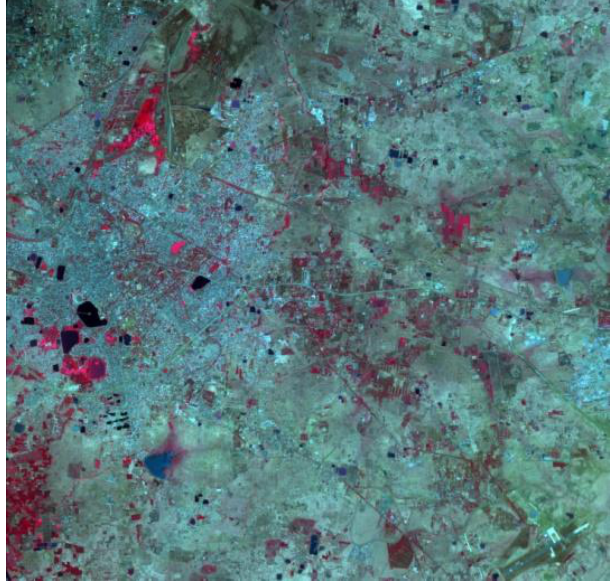
Figure 1. Original Uncorrected Resourcesat-1 LISS-4 multispectral satellites image, acquired on 22 th March 2009.